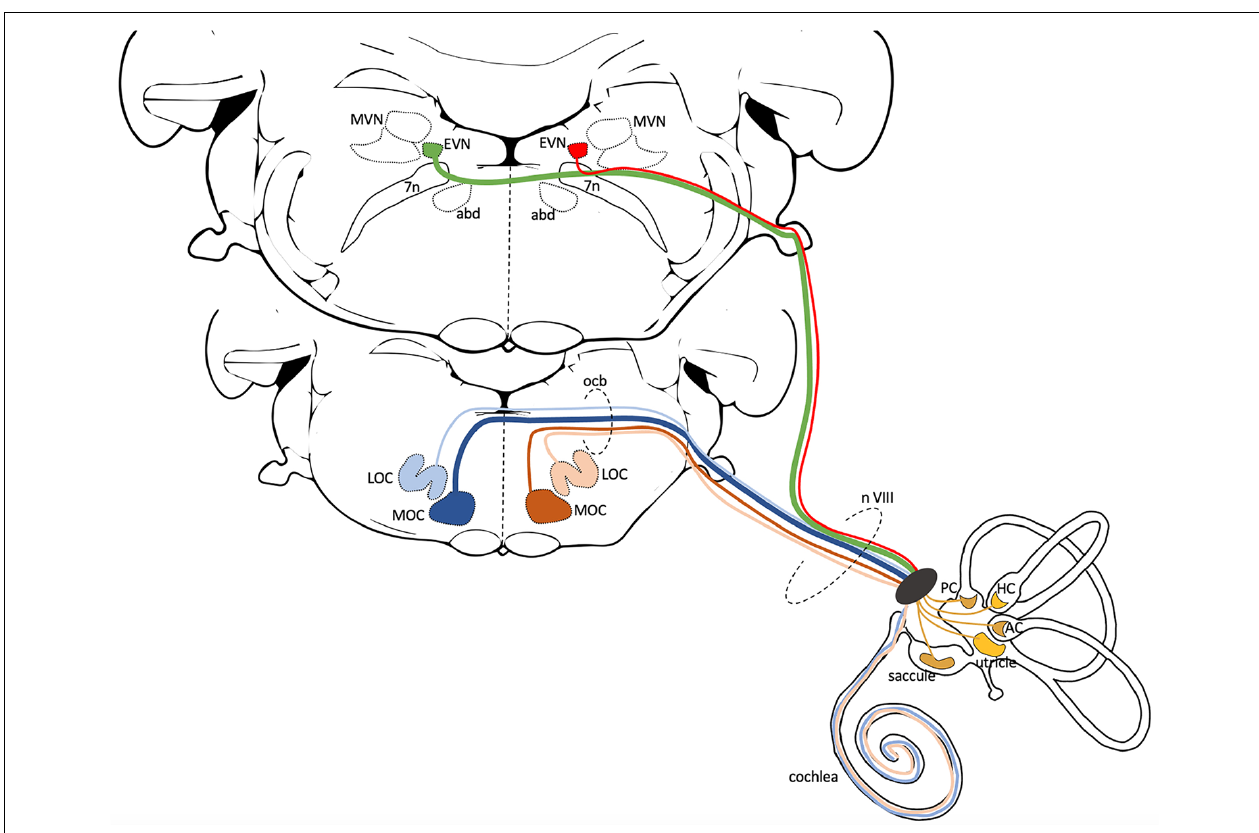
FIGURE 1 | Central anatomy of the Cochlear and Vestibular Efferent System. This schematic illustrates the generic central pathways of the cochlear and vestibular efferent systems in mammals. Both efferent systems have ipsi- and contralateral projections, but here only the left side projections are illustrated. The lower brainstem slice (more rostral) shows the position of lateral and medial olivocochlear neurons (LOC, MOC). Blue lines represent contralateral, beige and brown lines represent ipsilateral efferent cochlear projections. In mice, the majority of the 475 cochlear efferent axons that innervate a cochlea are LOC neurons ( ∼ 65%). Most of these LOC axons originate from the ipsilateral side (beige—99%) with only a few from the contralateral side (light blue—1%). MOC axons contribute ∼ 35% to cochlea efferent input. Most of the MOC axons originate from the contralateral side (dark blue—75%) and the remaining from the ipsilateral side (brown—25%) (Campbell and Henson, 1988). The upper brainstem slice (more caudal) shows the position of EVN, dorsolateral to the facial nerve and genu (7n) and neighboring regions, the Medial Vestibular Nucleus (MVN), and the abducens nucleus (abd). To date, in mice, it is unclear the number or percentage of EVN cells that send ipsilateral (red line), contralateral (green line), or perhaps bilateral projections. The cochlear and vestibular efferents join the vestibulocochlear nerve (n VIII) as it exits the brainstem and travel together to the inner ear. The cochlear projections innervate the inner hair cells (LOC efferents) and outer hair cells (MOC efferents) in the organ of Corti. The efferent vestibular projections innervate Type II hair cells, afferent nerve fibers, and afferent calyx terminals in the five vestibular organs: saccule, utricle, anterior crista (AC), horizontal crista (HC), posterior crista